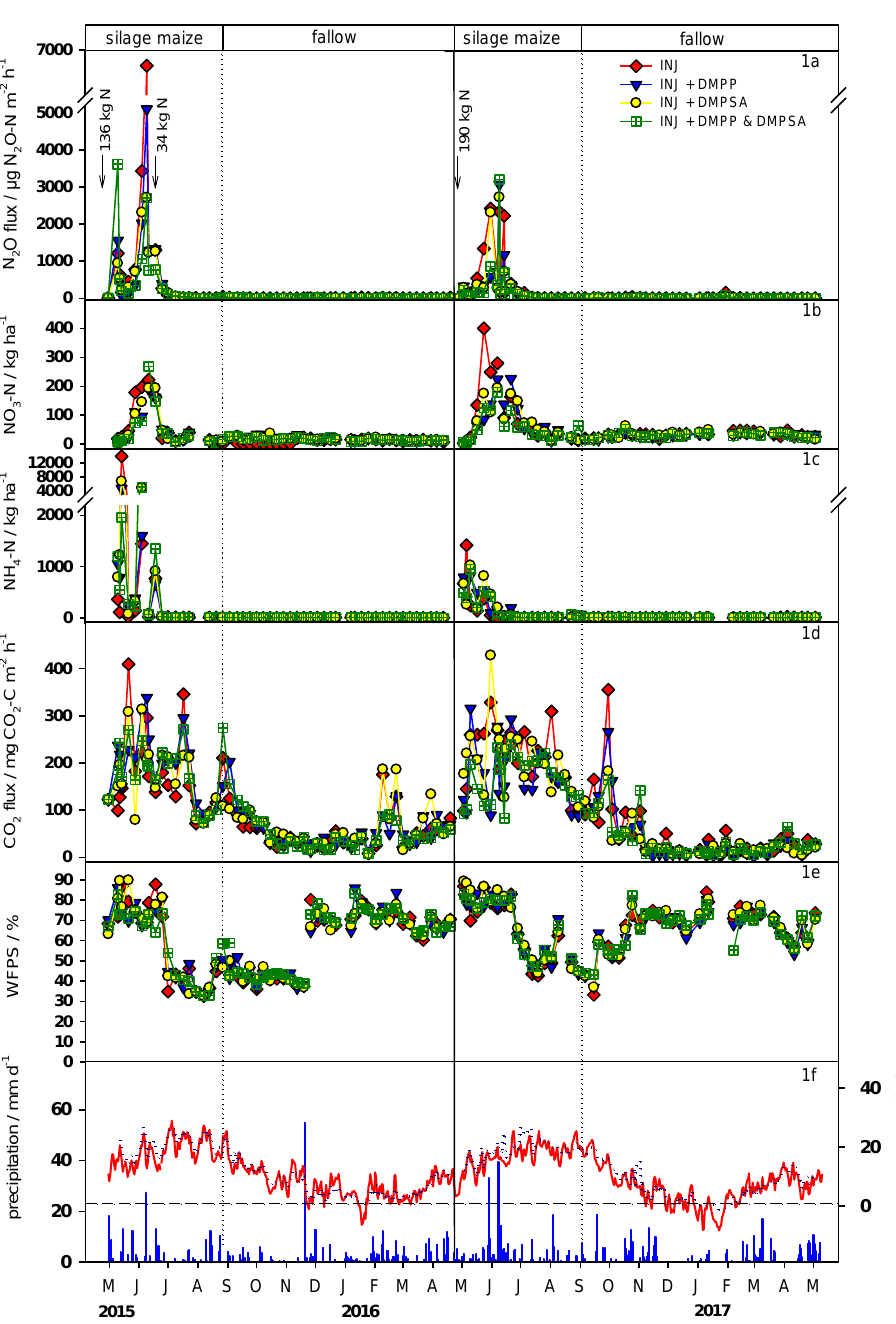
Figure 1. Mean N 2 O flux rates ( n = 4) ( a ), NO 3 − -N contents (0 − 30 cm) ( b ), NH 4 + -N contents (0 − 30 cm) ( c ), mean CO 2 soil flux rates ( n = 4) ( d ), and water-filled pore space (WFPS, 0−30 cm) ( e ) in the slurry injection treatment without NI (INJ), and in the treatments with DMPP (INJ + DMPP), with DMPSA (INJ + DMPSA), and with the combination of DMPP&DMPSA (INJ + DMPP&DMPSA). Mean air temperature (solid line), soil temperature in 0.1 m depth (dotted line), and daily precipitation (bars) ( f ). Arrows indicate fertilization measures. Error bars were omitted for clarity. Data from the INJ treatment were taken from Herr et al. [19]. During the cropping seasons, NO 3− -N and NH 4+ -N contents are shown for the slot area.